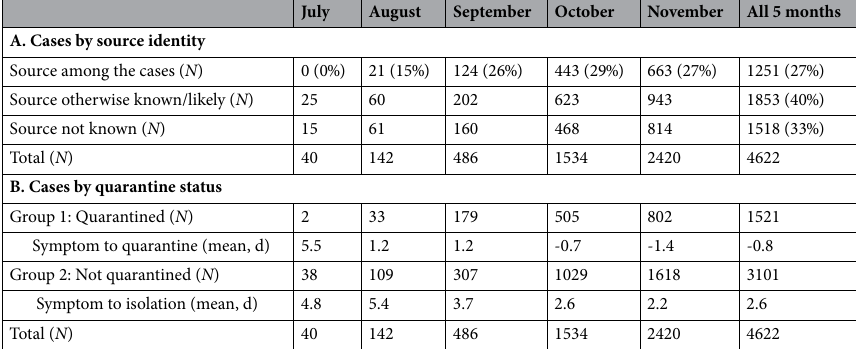
Table 1. Cases in Helsinki between July 1 and November 31, 2020. Panel A: numbers of cases by identity of infection source (source within the dataset/source otherwise known or likely/source unknown). Panel B: numbers of cases and the mean time until quarantine (Group 1) or isolation (Group 2). Group 1 includes cases who were quarantined within ± 14 days from symptom onset ( N = 1521 ). Group 2 includes the rest ( N = 3101 ).